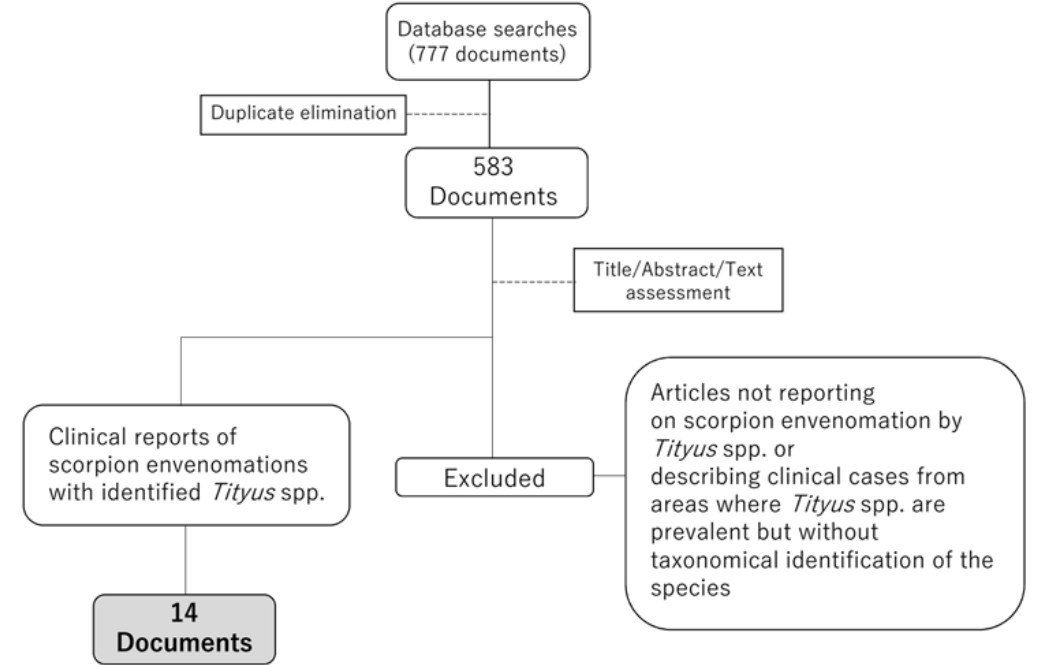
Figure 4. Flow diagram of the review for selecting reports on scorpion envenomation cases from Amazonia caused by taxonomically confirmed Tityus spp. for further analysis of clinical